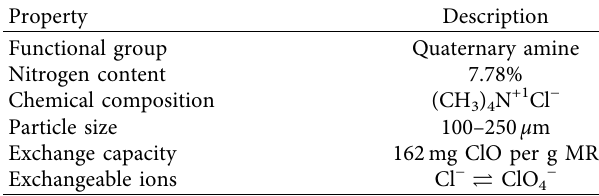
Table 1: Properties of modifed reed